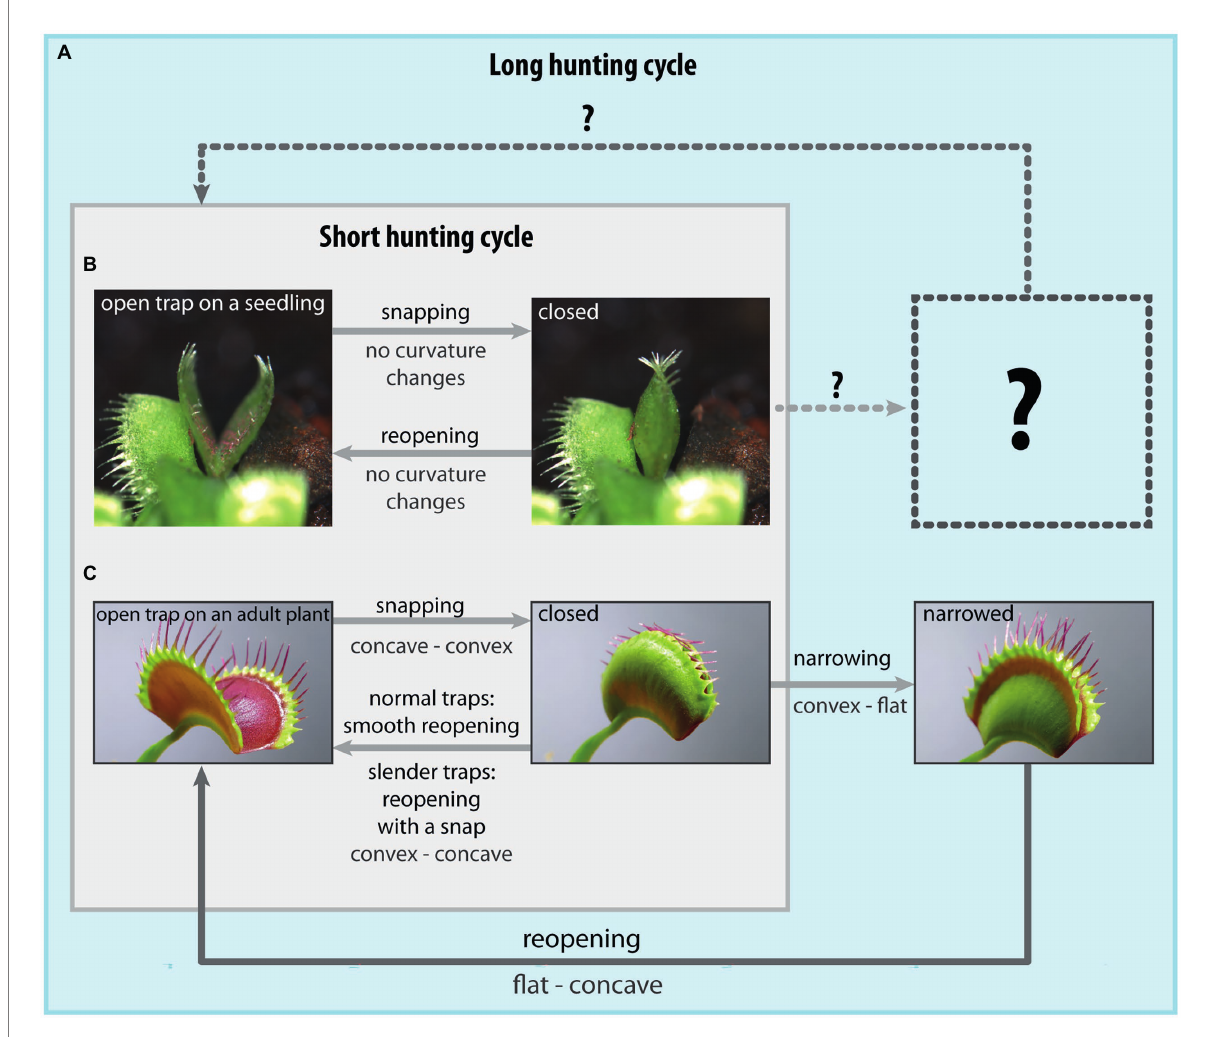
FIGURE 1 Diagram depicting the range of motions and geometry changes performed by Dionaea muscipula snap-traps during short and long hunting cycles. (A) – The long hunting cycle in juvenile and adult plants includes successful capture, retention and digestion of prey, whereas during the short hunting cycle, (B,C) no prey is successfully captured, leading to an immediate trap reopening after snapping. The mode of trap reopening in traps from adult plants depends on trap geometry, with slender traps sometimes incorporating a snap-through transition. (B) – A trap from a juvenile plant in the “ready-to-snap” and closed configurations, (C) – A trap from an adult plant in the “ready-to-snap” and closed configurations. Snapping in traps of juvenile plants is not characterized by the snap-buckling instability, otherwise speed-boosting the motion of the adult traps hinting at different closing mechanics. The subsequent trap actuation and deformation processes involved in prey retention and digeston in traps of the juvenile plants are completely unknown so far (indicated by question marks). Images of traps from the juvenile plants were adapted from Poppinga et al. (2016), images of traps of the adult plants were adapted from Bauer et al.